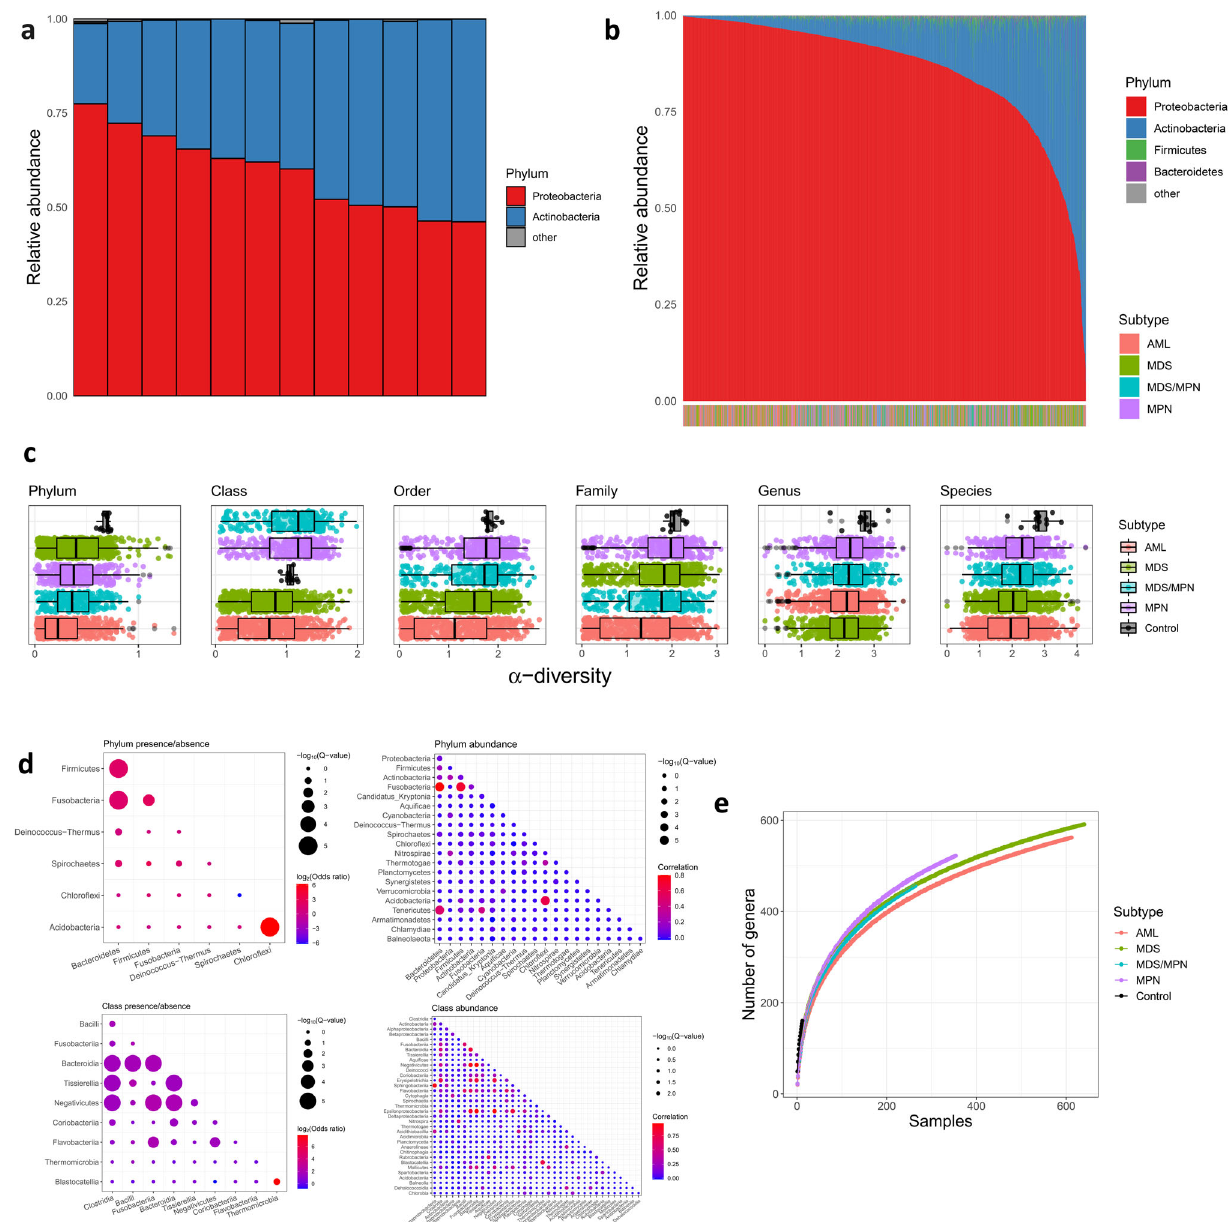
Fig. 3 The bacterial landscape in the bone marrow/blood of myeloid malignancy patients and controls. a Relative abundances of phyla are represented by a colored bar for each of the 12 control bone marrow samples. b The 1870 colored bars, one for each patient, are ordered left to right by decreasing Proteobacteria relative abundance. The disease subtype of each patient is indicated in the horizontal color bar at the bottom (the enrichment of AML patients among the Proteobacteria-dominant samples is apparent by the color shift at the left side of the bar). c α -diversity of each sample within each taxonomic level, strati fi ed by case/control status and disease subtype. Boxplots are ordered top to bottom in decreasing median α -diversity, with sample sizes 12, 612, 640, 264, and 354 for controls, AML, MDS, MDS/MPN, and MPN, respectively. In boxplots, bounds of box indicate fi rst and third quartiles, center line indicates median, and whiskers extend to ( fi rst quartile − 1.5 × IQR) and (third quartile + 1.5 × IQR) or extrema, whichever is less extreme (here IQR = interquartile range, i.e. third quartile – fi rst quartile). d Plot showing pairwise concordance/discordance of taxa, at the phylum (top) and class (bottom) levels, both with regard to presence/absence (left) and abundance (right). Sizes of the circles indicate statistical signi fi cance, and color indicates strength and direction of association (odds ratio or Pearson correlation). Only taxa with signi fi cant ( Q < 0.1) concordance/discordance with at least one other taxon are shown. e Rarefaction plot showing number of genera as a function of number of patients, strati fi ed by disease subtype. For each patient number n , a random sample of n patients was drawn from each subtype, 500 times. Solid curves represent the mean across the 500 replicates. For control samples, sampling is performed exhaustively (that is, all possible subsets of n individuals are selected for each n = 1,2, …